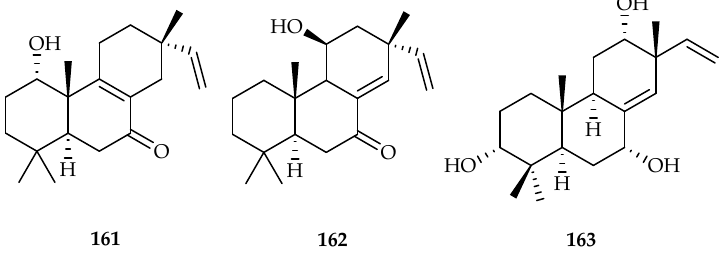
Figure 67. Structures of compounds 161 [105] and 162 [105] and alatavnol A 163 [106].